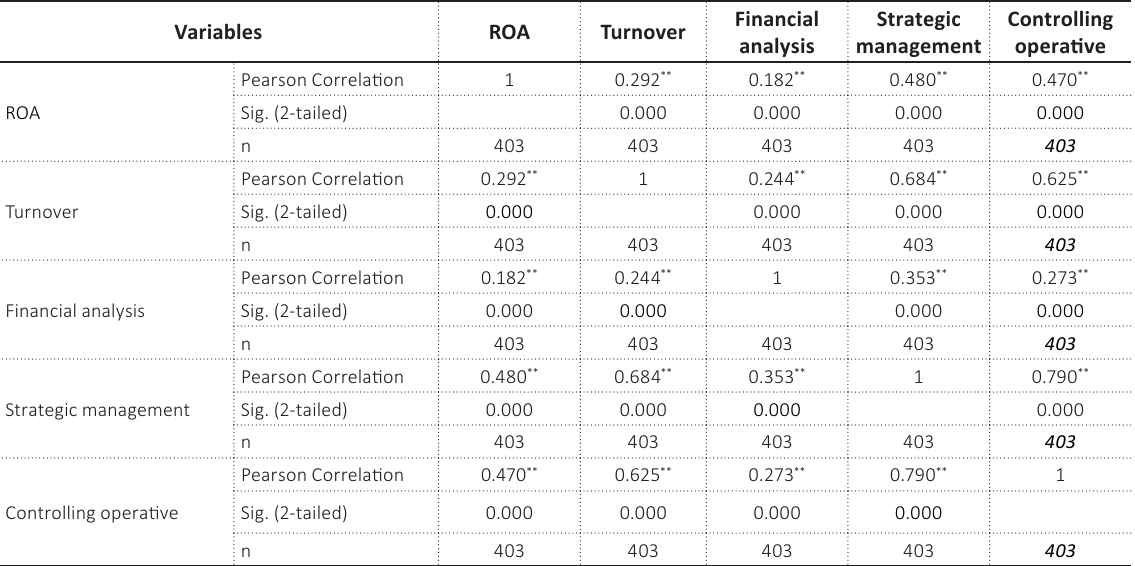
Table 1. Pearson correlation